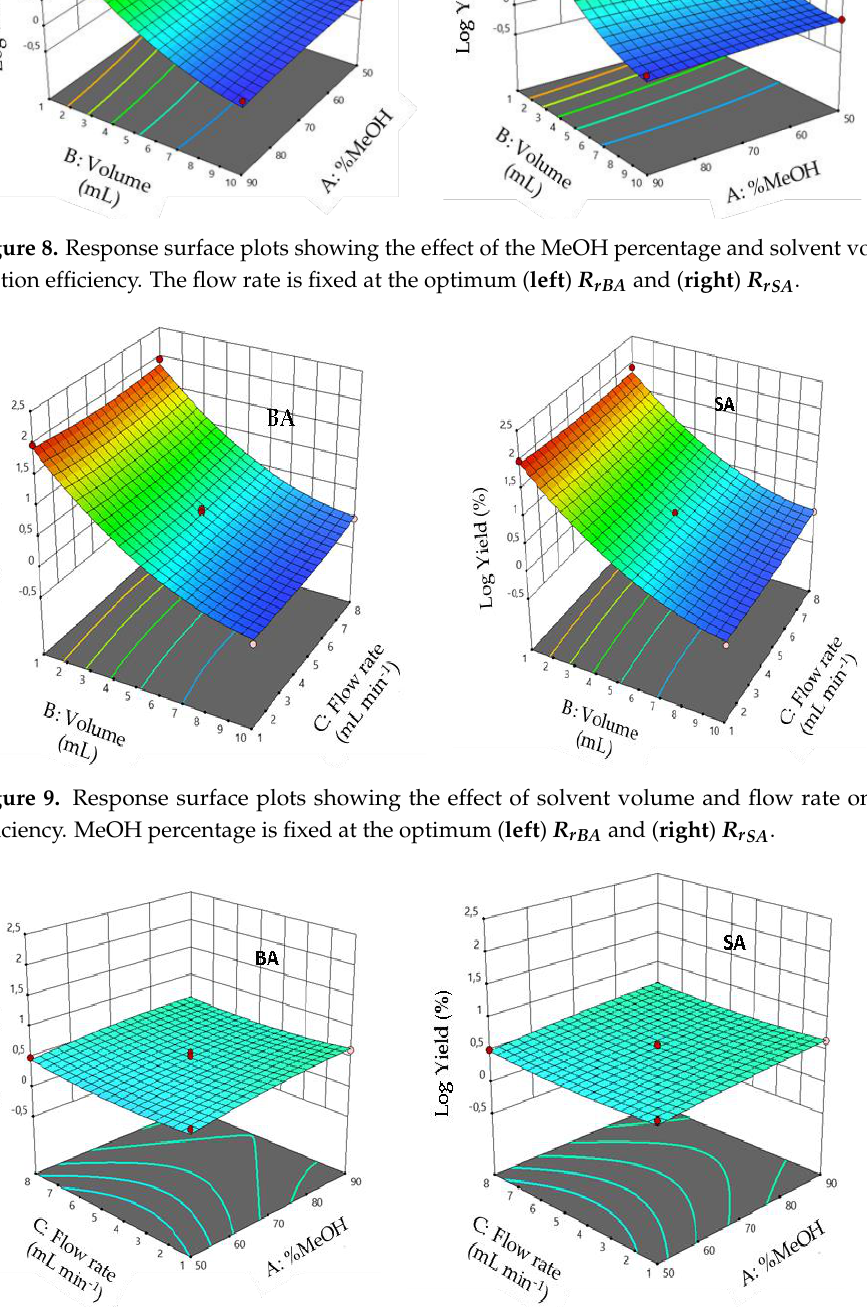
Figure 10. Response surface plots showing the effect of the MeOH percentage and flow rate on elution yield. Solvent volume is fixed at the optimum ( left ) R rBA and ( right ) R rSA .